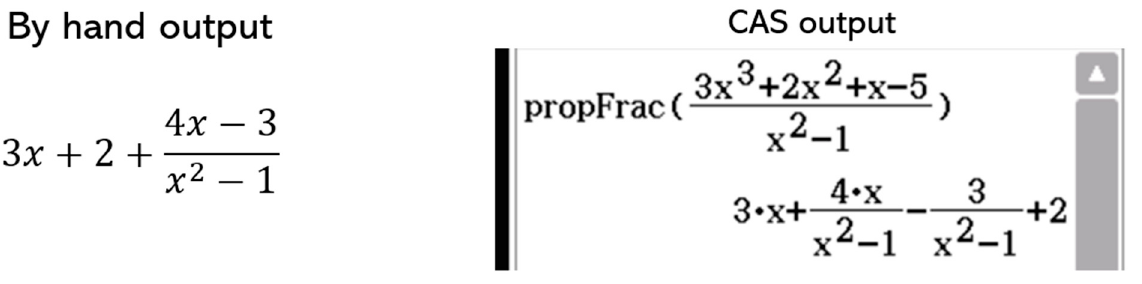
Figure 6. Students using CAS must be versatile in recognizing equivalent mathematical expres- sions.